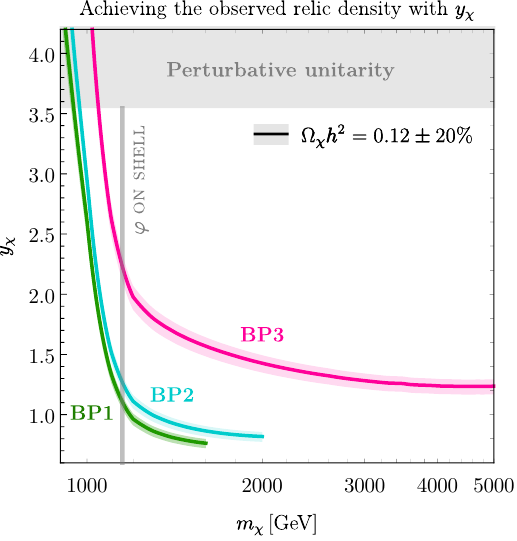
Figure 16 . Values of y χ producing the observed relic density as a function of m χ in all three